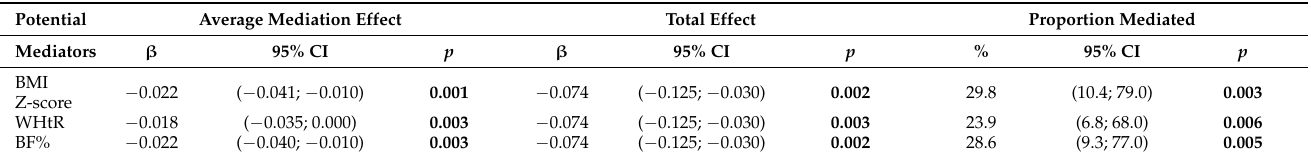
Table 3. Mediation analysis for the association between adiponectin and FTO rs9939609 genotype, with several measures of adiposity modelled as potential